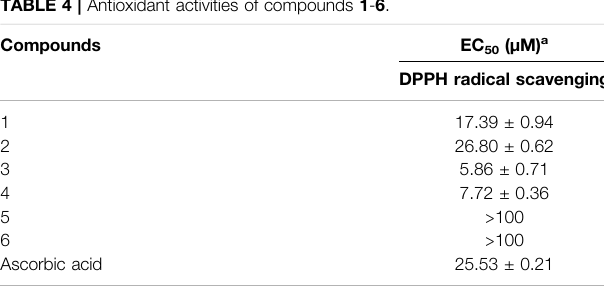
TABLE 4 | Antioxidant activities of compounds 1 - 6